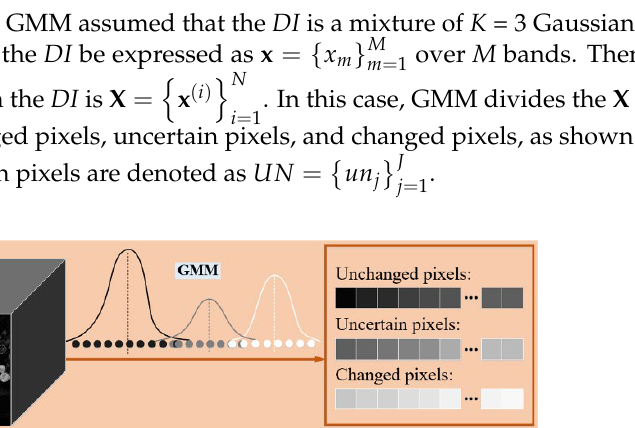
Figure 2. The function of SLIC. ( a ) The fifth band DI of the USA dataset, ( b ) SLIC segmented superpixels with different colors, ( c ) the ground-truth for multiple change classes with different colors. The boxed circular area in each image is the same position.